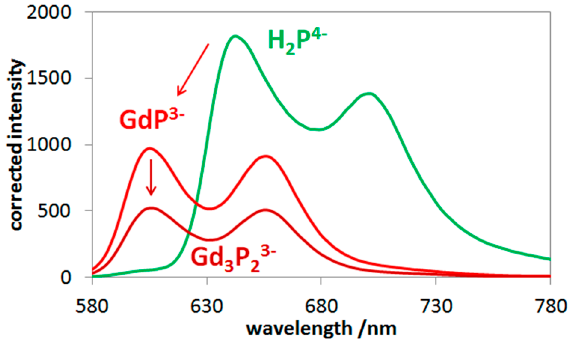
Figure 4. Individual S 1 -fluorescence spectra of gadolinium(III) mono- and bisporphyrin as well as the corresponding free base.